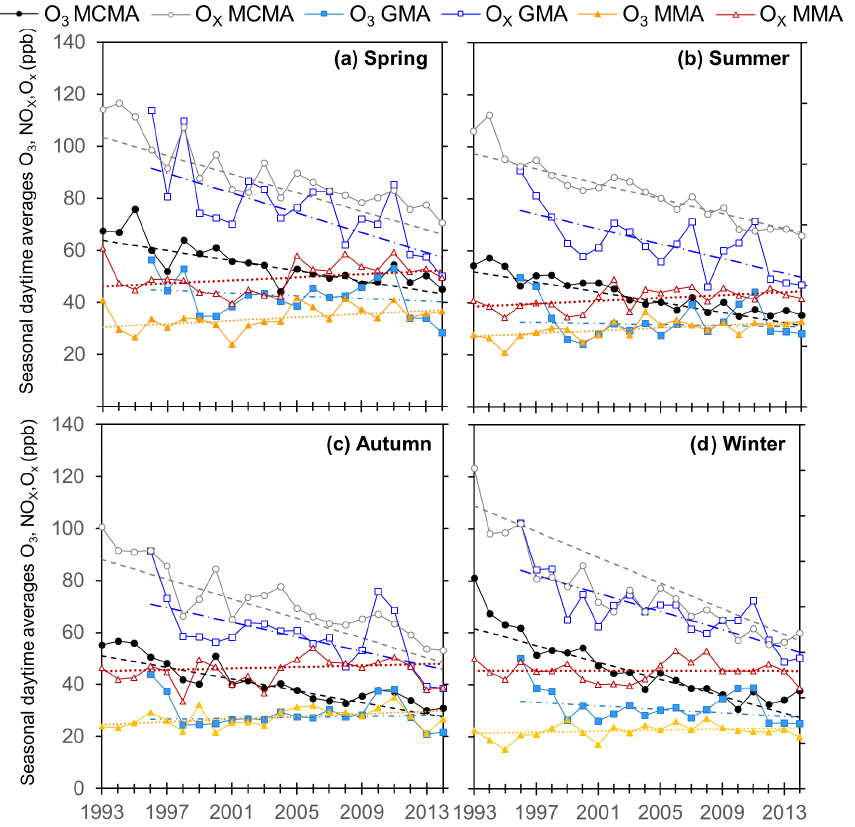
Figure 9. Seasonal trends in O 3 and O x for the MCMA and MMA during 1993–2014 and for the GMA during 1996–2014. Each data point represents the average of the 3-month period that defines the season. The dashed lines show the Sen trend.